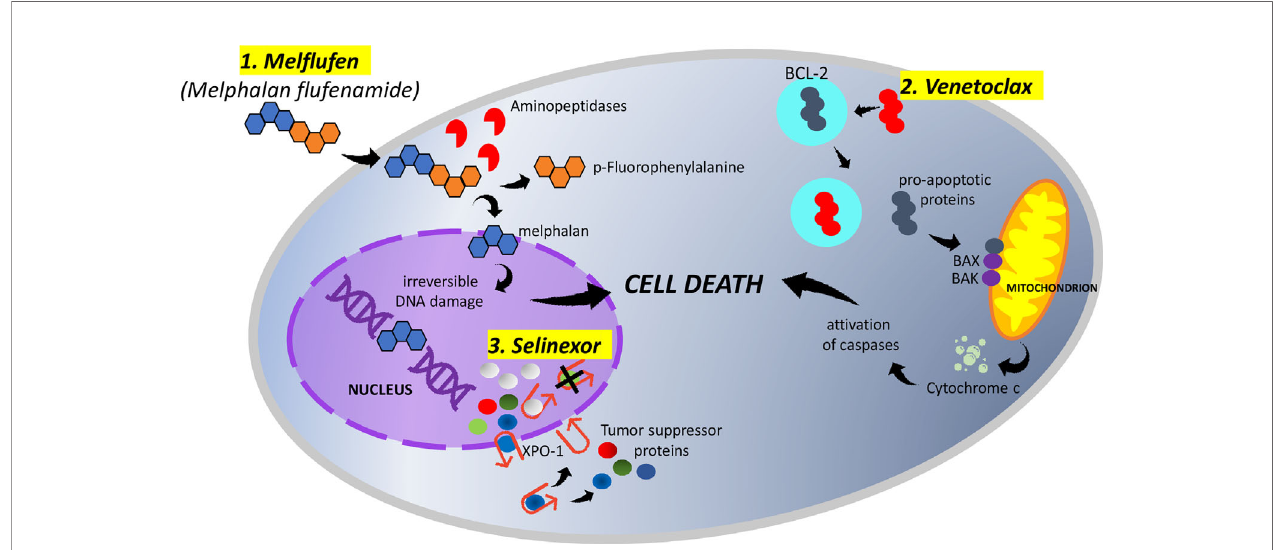
FIGURE 1 | 1. Melphalan fl ufenamide (mel fl ufen) is highly lipophilic and rapidly diffuses across the membranes of myeloma cells. Once inside the cell, aminopeptidases cleave mel fl ufen into melphalan and p- fl uorophenylalanine. melphalan accumulates in myeloma cells and, within the nucleus, induces irreversible DNA damage and apoptosis. 2. Venetoclax binds selectively to BCL-2, freeing pro-apoptotic proteins. The released pro-apoptotic proteins associate with the apoptotic effectors BAX and BAK and induce the permeabilization of the mitochondrial outer membrane. The cytochrome c released activates caspases and triggers cell death. 3. Myeloma cells overexpress XPO-1, causing the increased export of tumor-suppressor proteins from the nucleus. Selinexor (represented by white spheres), binding to XPO-1, inhibits the nuclear export of tumor-suppressor proteins (represented by green, blue, and red spheres). The accumulation of tumor suppressors in the nucleus ultimately leads to cell cycle arrest and apoptosis of multiple myeloma